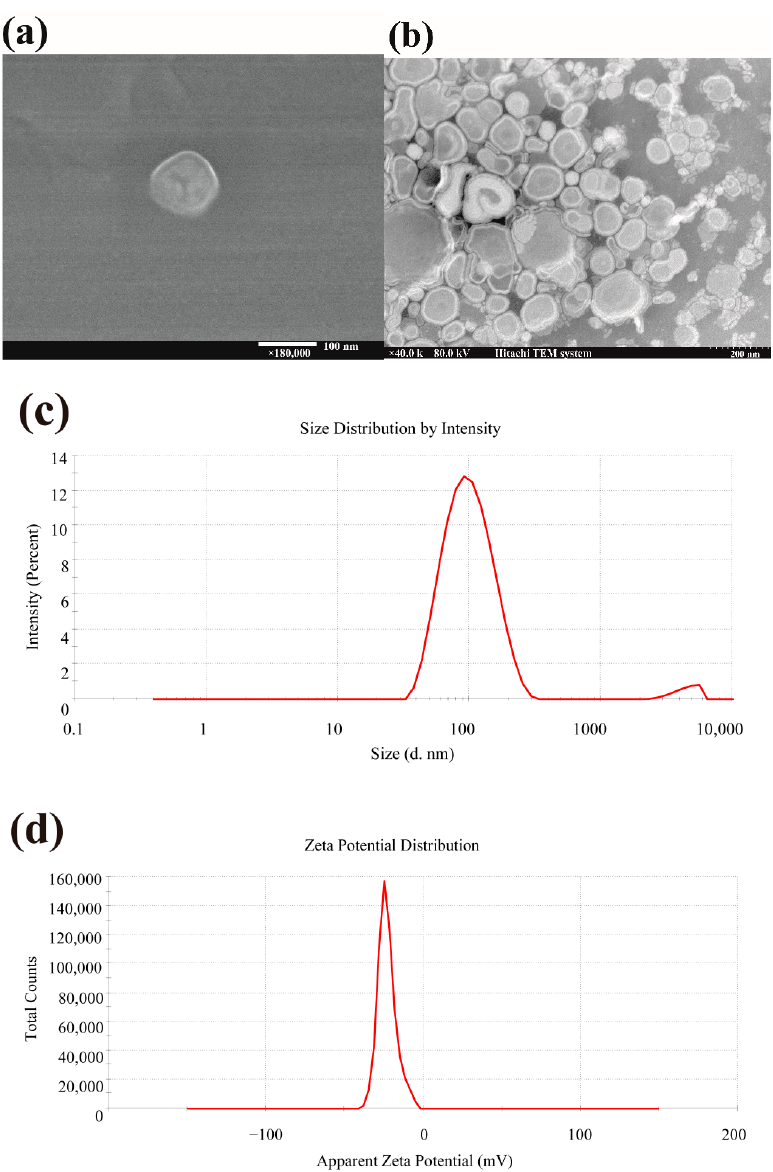
Figure 2. Characterization of CPD photolyase nanoliposomes. ( a ) Scanning electron microscope (SEM) image; ( b ) transmission electron microscope (TEM) image; ( c ) particle size distribution; ( d ) zeta